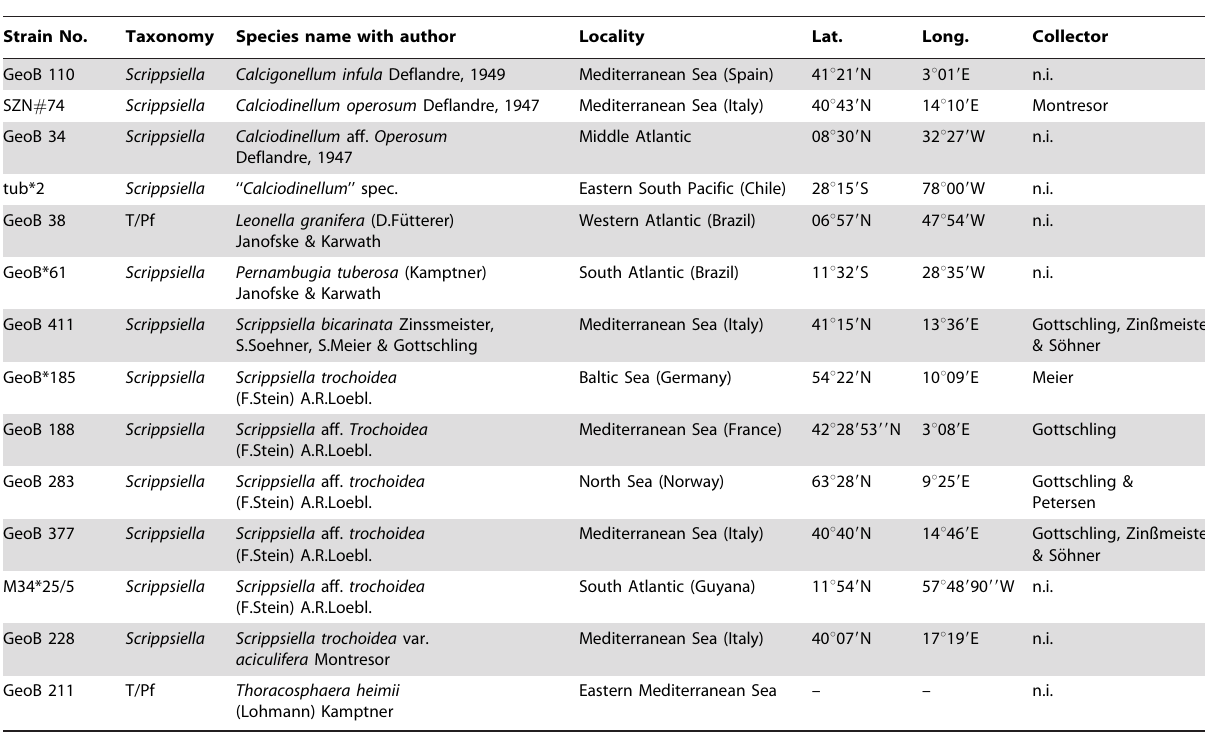
Table 1. Species list of TEM investigations (abbreviations: n.i., not indicated).